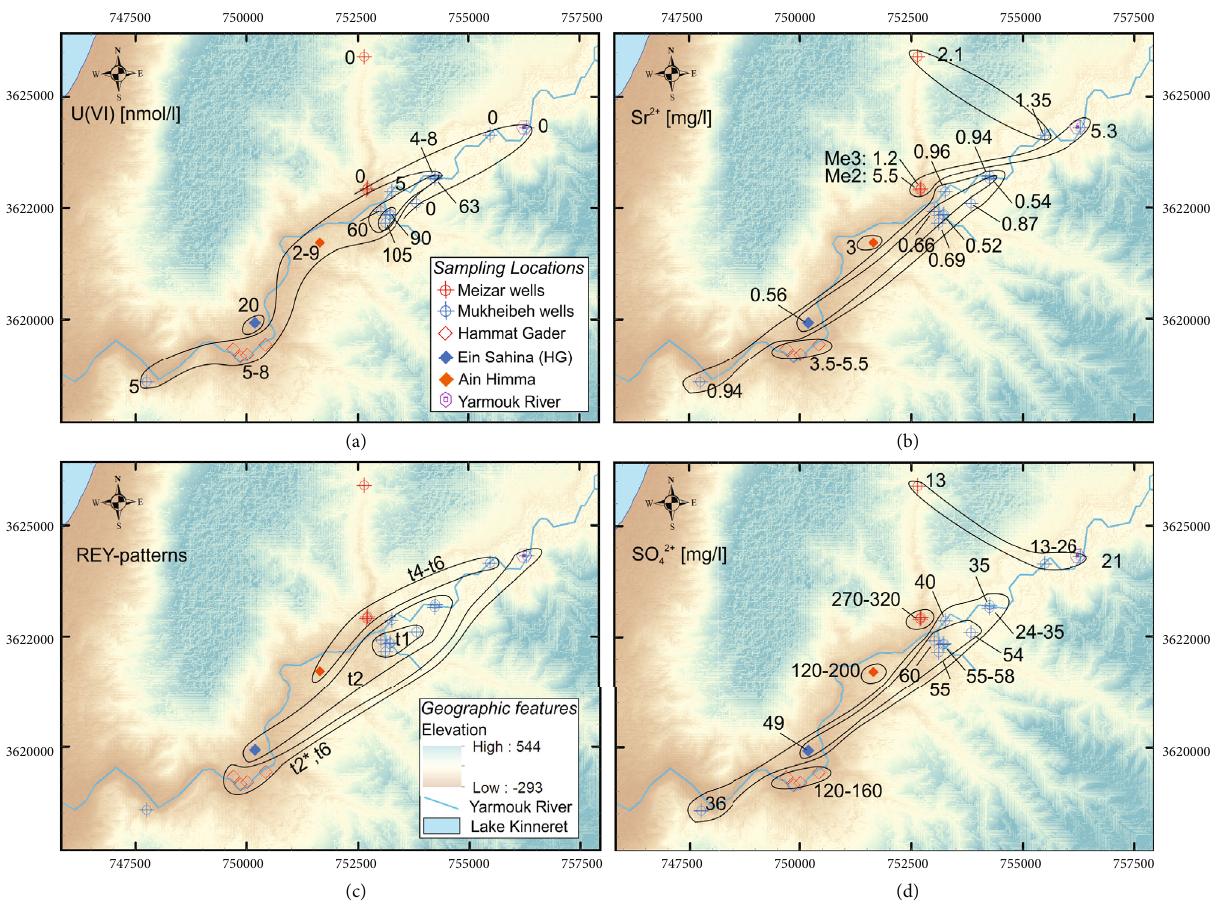
Figure 11: Regional distribution of U(VI) (a), Sr 2+ (b), rare earth distribution patterns (c), and sulfate (d) in the Lower Yarmouk Gorge. Legends given in (a) and (c) are representative for the entire Figure